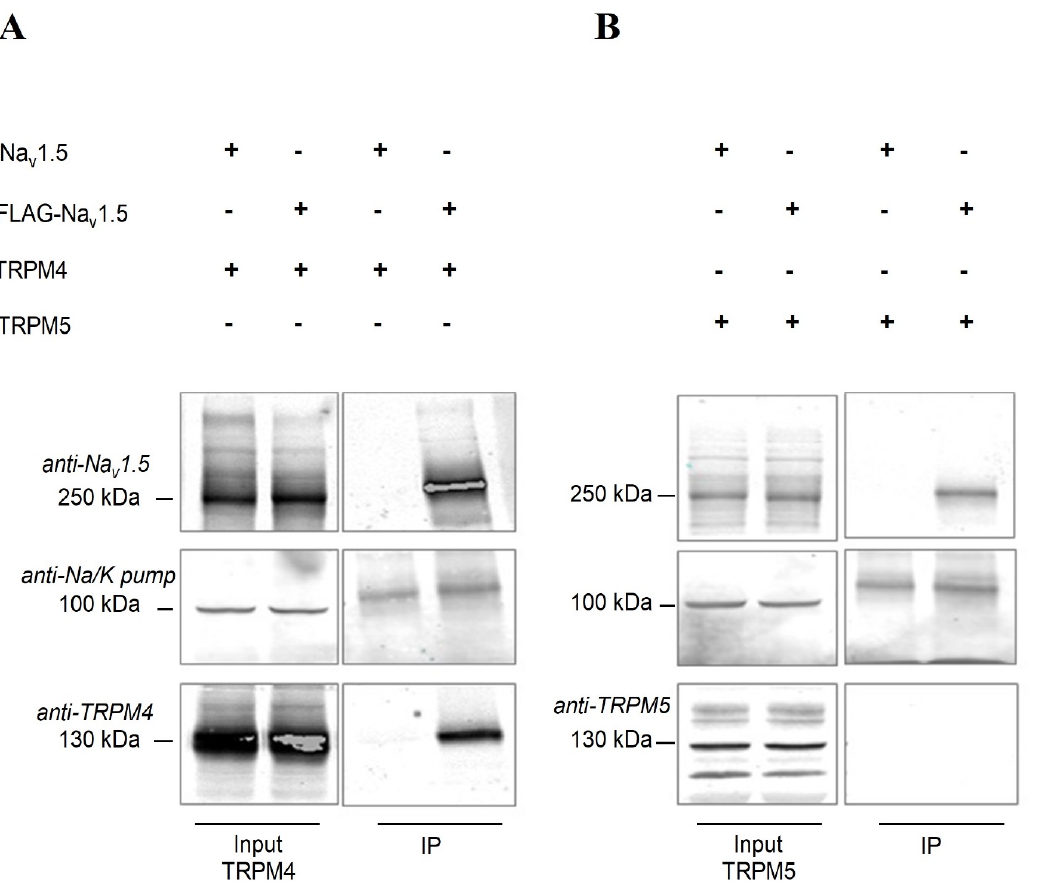
Figure 7. Co-immunoprecipitation of Na v 1.5 and TRPM4 in HEK-293 cells. ( A ) Left panel: Input signals confirming the expression of Na v 1.5 with or without FLAG tag and TRPM4. The alpha subunit of the Na/K pump was used as a loading control. Right panel: In the immunoprecipitated (IP) fraction, the signal was observed only in the presence of FLAG-Na v 1.5 and TRPM4. ( B ) Left panel: Input signals confirming the expression of Na v 1.5 with or without FLAG tag and TRPM5. Right panel: In the immunoprecipitated fraction, no signal was observed for TRPM5, even though the IP of FLAG-Na v 1.5 was successful.